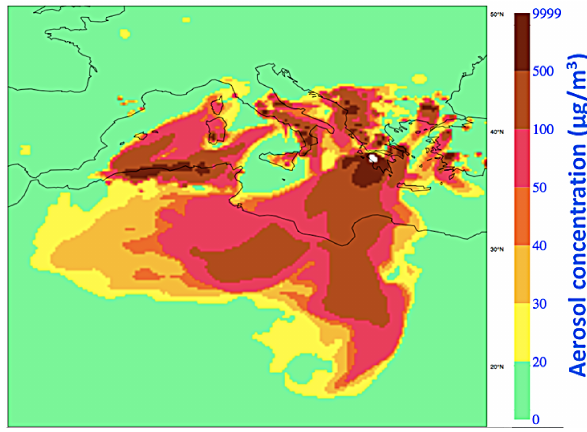
Figure 15. Simulated maximum 24h running mean smoke aerosol concentration (µgm − 3 ) recorded at the surface between 23 Au- gust and 3 September 2007, based on the methodology outlined in Sect. 5.6. The values are an upper limit due to unrealistically low smoke injection height into the atmosphere. The World Health Or- ganisation (WHO) air quality guidelines (WHO, 2006) set a limit of 25µgm − 3 for the surface concentration of fine-mode particulate matter (PM 2 . 5 ) averaged over a 24h